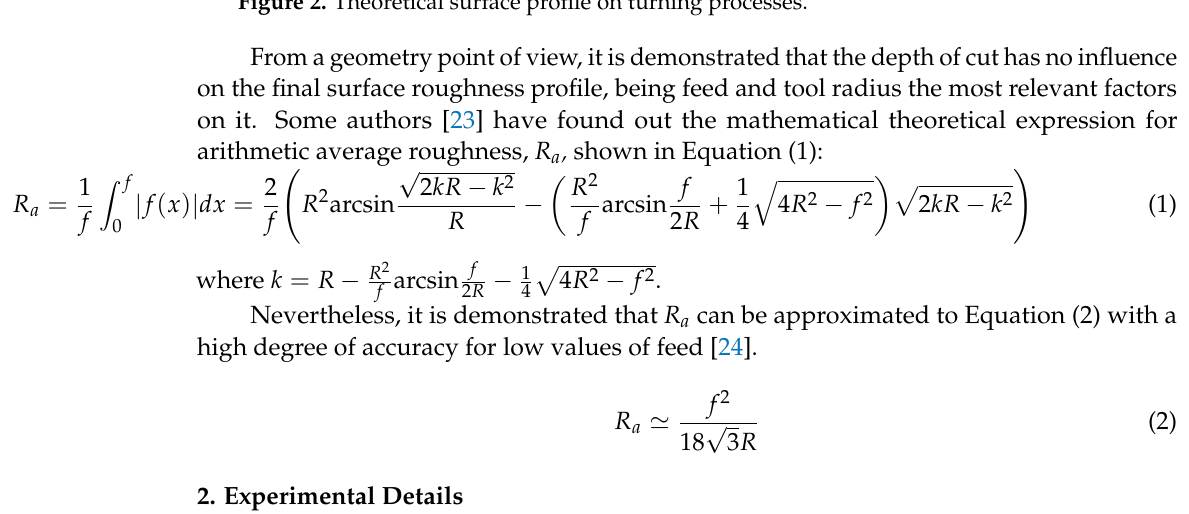
Figure 2. Theoretical surface profile on turning processes.